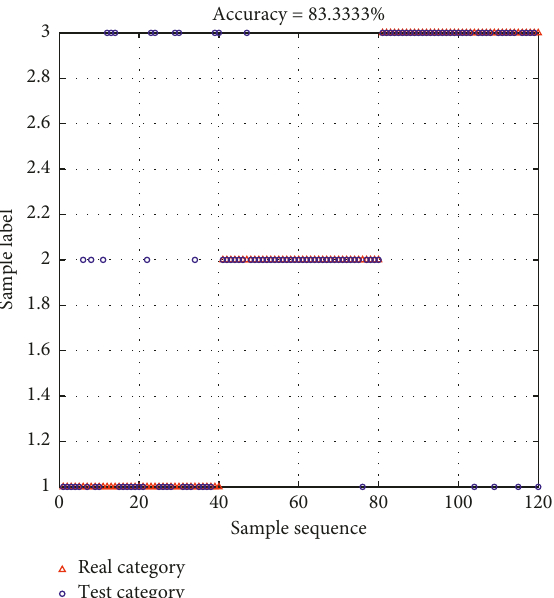
Figure 11: The spiral-bevel gear fault diagnostic results by using EMD-based permutation entropy and SVM.